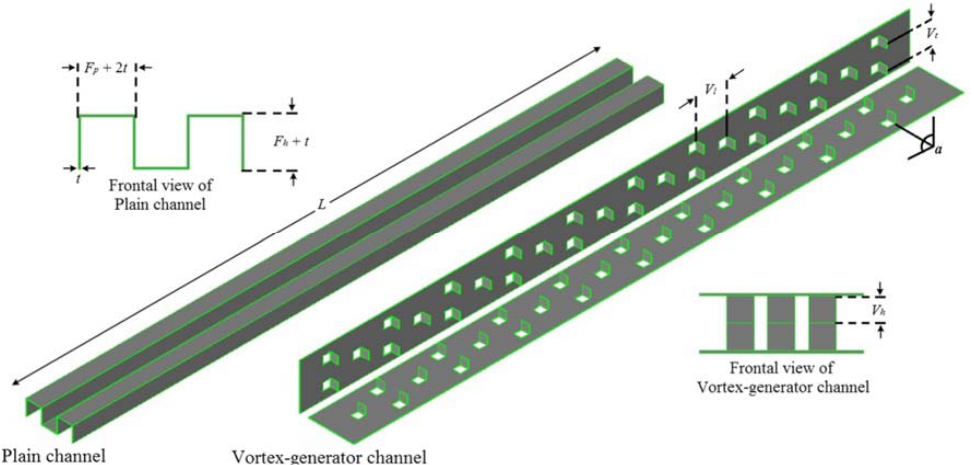
Figure 20. The studied geometry of the plain and vortex ‐ generator channel. Reproduced with permission from [207]. Springer Nature, 2015.